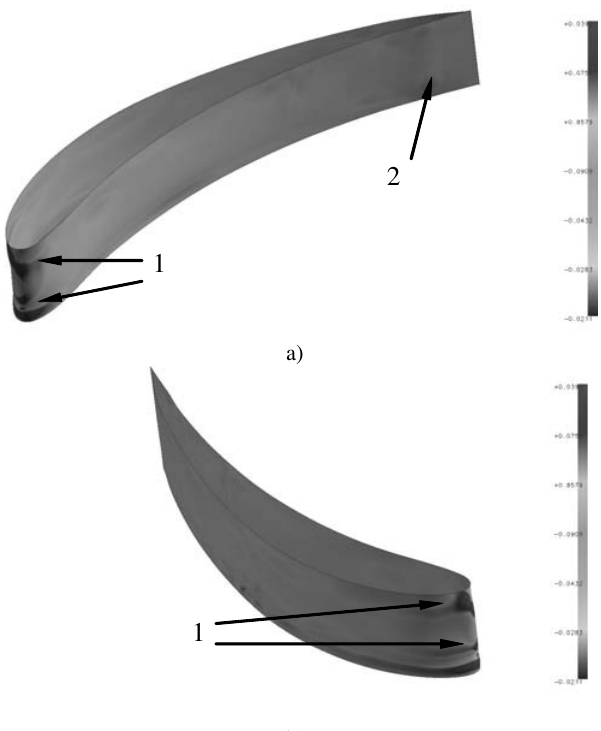
Fig 5. Analysis of surface created by means of relief control: 1 – discrepancies in surface caused by insufficient accuracy of point cloud; 2 – discrepancies caused by gap in point cloud As can be seen from both figures ,there are some discrepancies in the surface of the created wing section at the leading edge (1) and smaller ones near the trailing edge (2) of the wing (Figs 4 – 5).